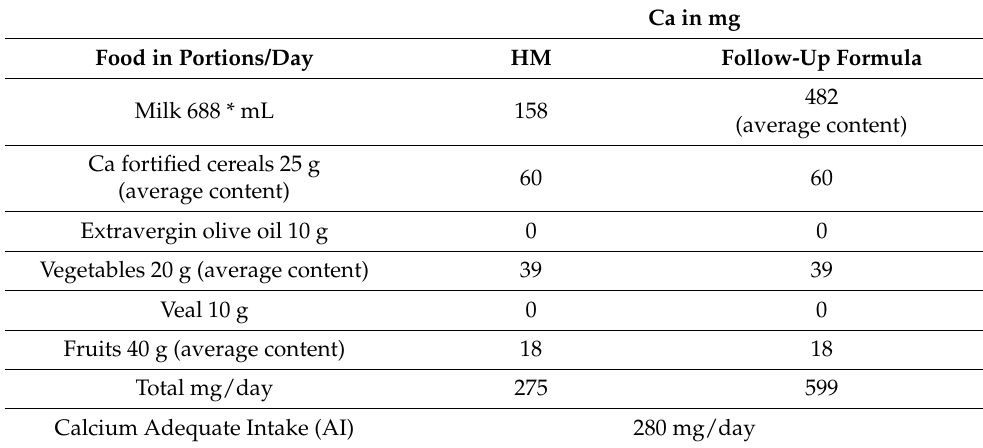
Table 4. Different Ca intake for a 6–8-month-old infant weighing between 7.3 and 8.6 kg [32] when breastfed or formula-fed, considering only one single complementary feeding scheme and an AI for Ca of 280 mg/day [34]. Milk quantity * is defined according to Dewey’s observational data [7]. Ca in mg Food in Portions/Day HM